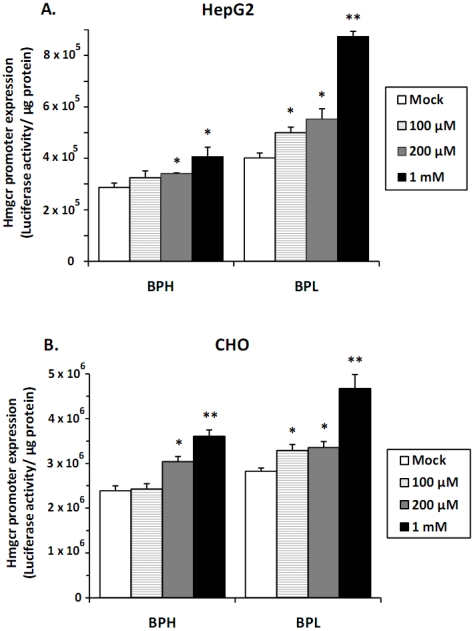
Effect of nicotine on Hmgcr promoter expression.HepG2 and CHO Cells were transfected with BPL/BPH Hmgcr promoter (−961 to +43 bp)/firefly luciferase construct. Transfected cells were treated with various doses of nicotine (100 µM, 200 µM and 1 mM) and incubated for 16–18 hrs. Cells were lysed and assayed for luciferase activity and protein concentration. Results were expressed as Mean ± S.E. of the ratio of firefly luciferase activity/µg protein. Each experiment was performed in triplicate and repeated at least three times. Nicotine significantly induced the expression of Hmgcr promoters in both HepG2 and CHO cells, to a greater extent in the case of BPL than BPH. (**) and (*) indicate p<0.01 and p<0.05 respectively, with respect to the mock (without stimulation).